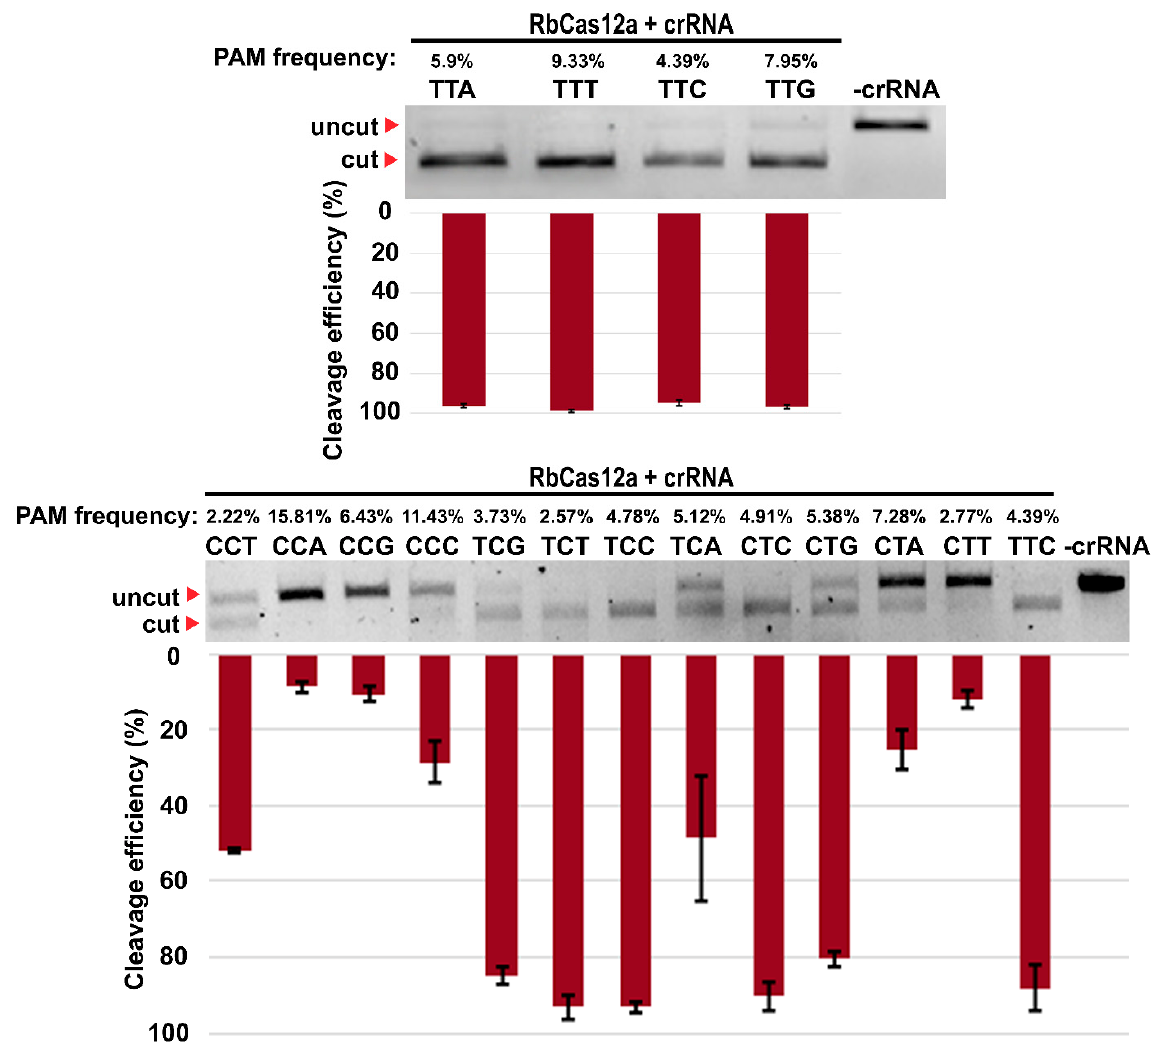
Figure 4. Investigation of RbCas12a PAM sequence by in vitro cleavage assay. The reactions contained 1.4 nM target DNA bearing the same protospacer but varying in the 5 ′ -PAM sequence (as indicated above the panel), 346 nM recombinant RbCas12a, and 550 nM crRNA (a 0.1:35:55 nM ratio). Reactions were incubated for 30 min at 37 °C, and products were resolved by agarose gel electrophoresis. PAM frequency refers to the frequency of exact PAM in the cleaved PAM library. Mean cleavage efficiencies and standard deviations from three independent experiments are shown below the